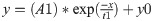
Escape distribution of ants under the effect of a repellent.(A), (B) The temporal evolution of the number of ants escaping through an exit size of 1w = 0.5 cm and other exit sizes (2w = 1.0 cm, 3w = 1.5 cm, 4w = 2.0 cm, 5w = 2.5 cm, and 6w = 3.0 cm); the data of one experimental repetition is shown. The solid line represents the result of nonlinear fitting. The flow of ants is divided into several groups. Solid line: y=(A1)*exp(−xt1)+y0; where y represents the number of escaped ants, and x represents time.